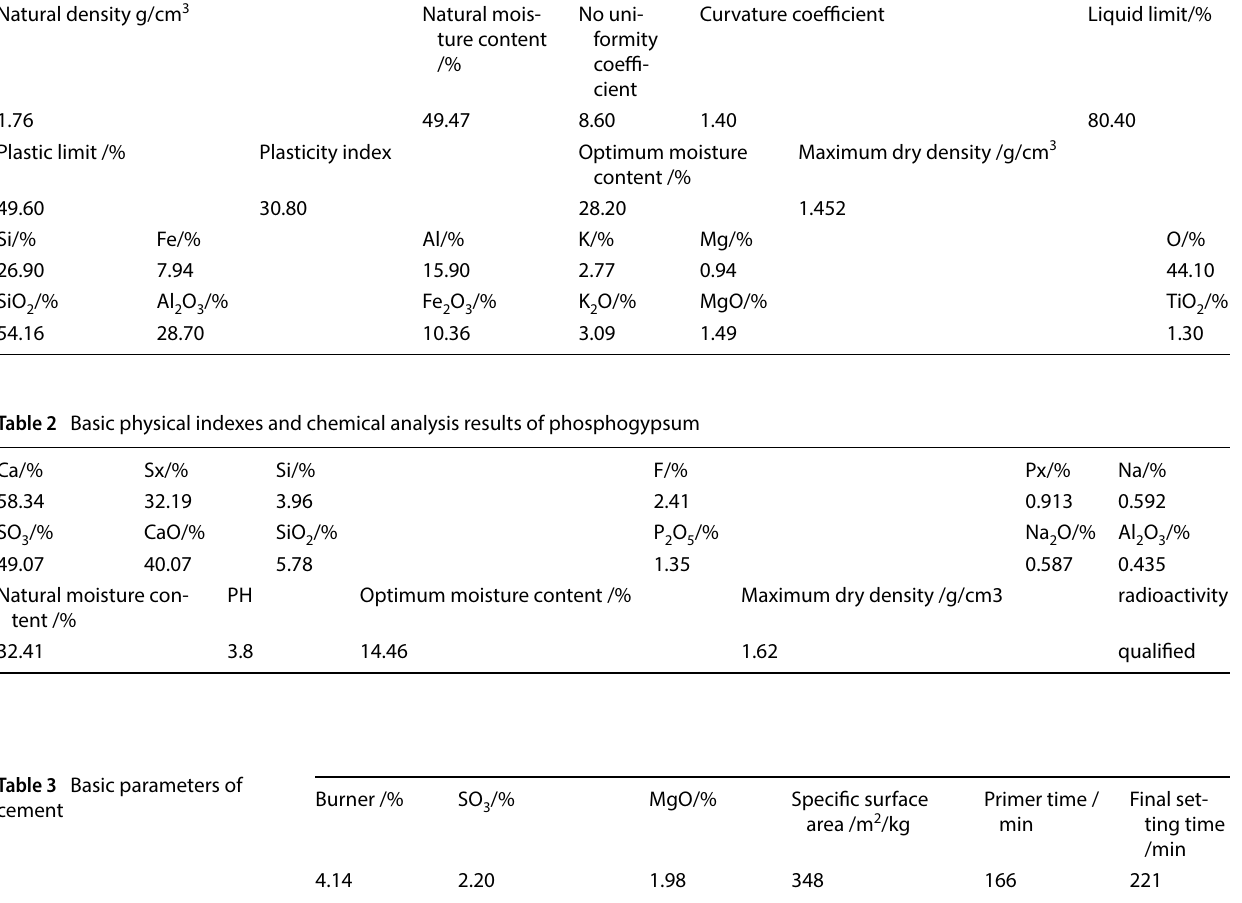
Table 1 Basic physical and chemical analysis results of red clay Natural density g/cm 3